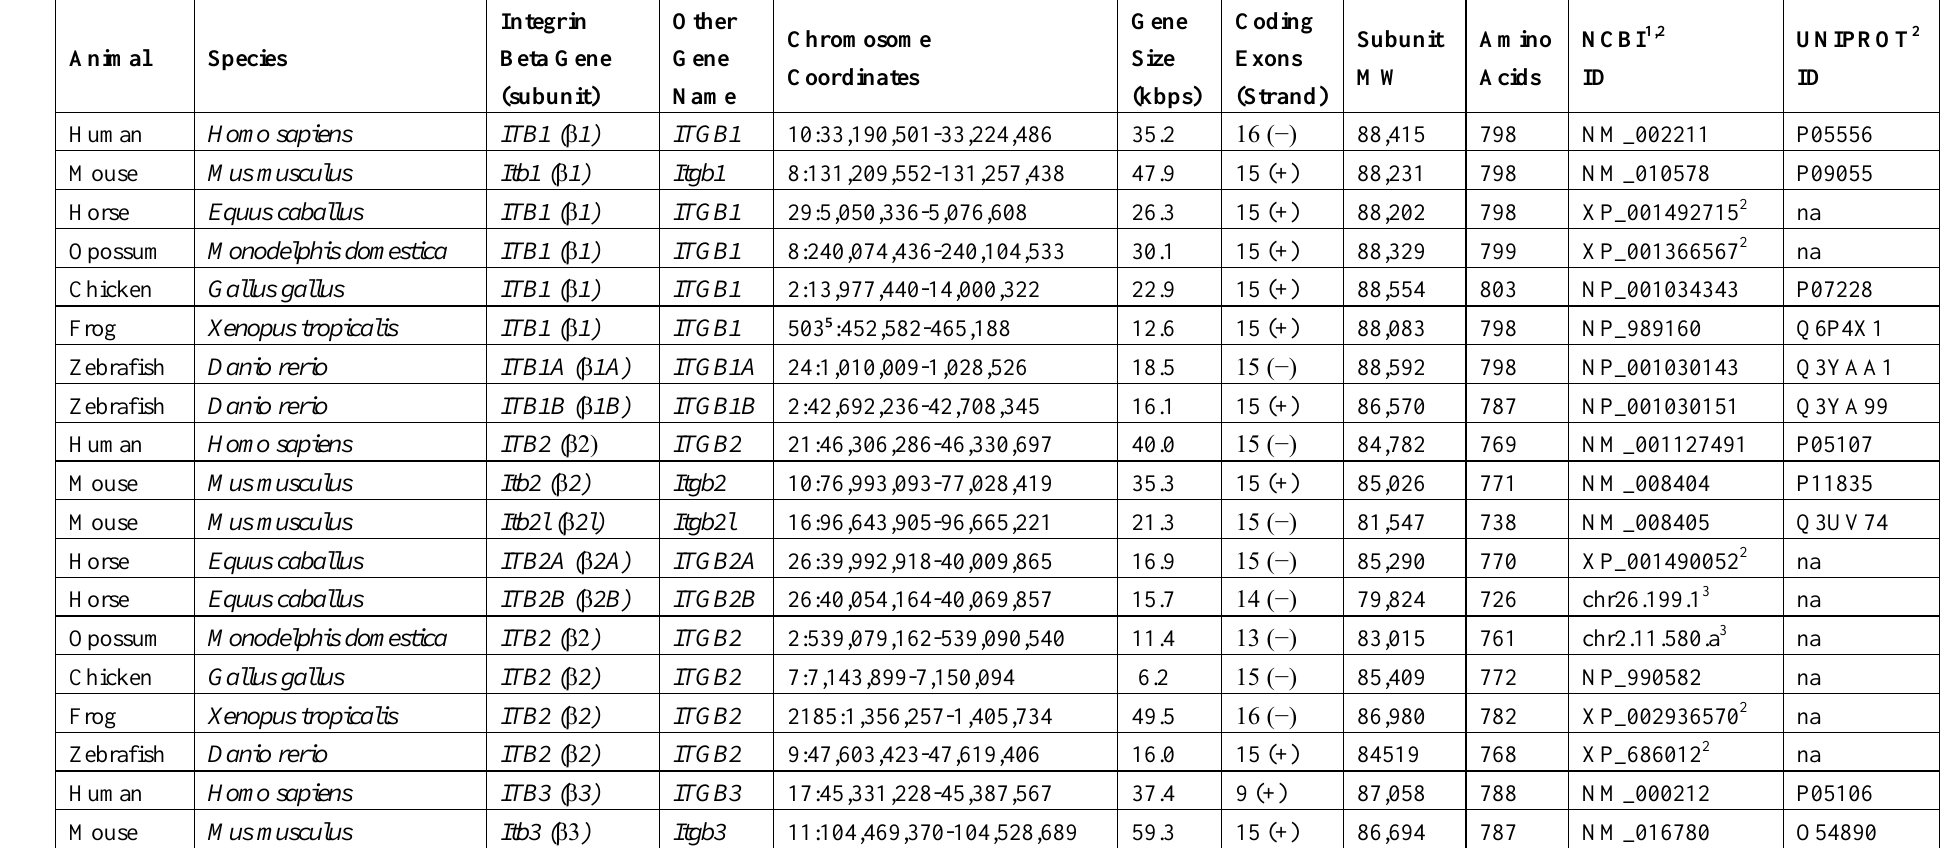
Table 1. Vertebrate beta integrin and nematode beta integrin-like genes and proteins. RefSeq: the reference amino acid sequence; 1,3 predicted Ensembl amino acid sequence; 2 not available; 4 Contig refers to a DNA scaffold for sequencing analyses; GenBank IDs are derived NCBI http://www.ncbi.nlm.nih.gov/genbank/; Ensembl ID was derived from Ensembl genome database http://www.ensembl.org/; UNIPROT refers to UniprotKB/Swiss-Prot IDs for individual acid lipases (see http://kr.expasy.org/); bps refers to base pairs of nucleotide sequences; pI refers to theoretical isoelectric points; the number of coding exons are